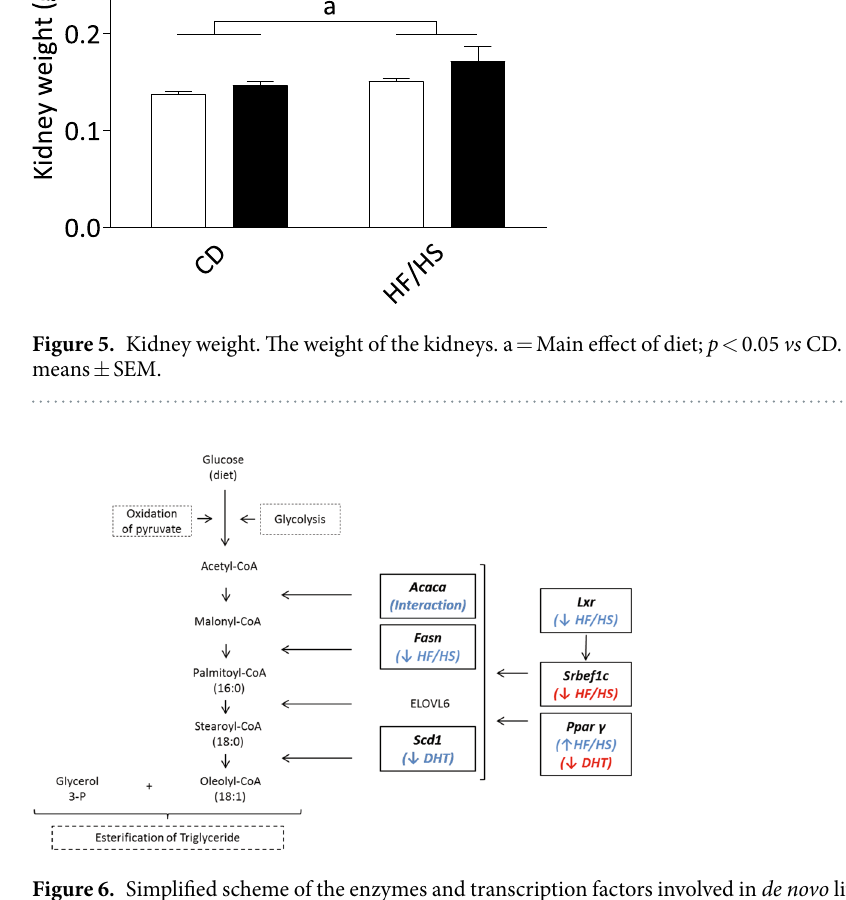
Figure 6. Simplified scheme of the enzymes and transcription factors involved in de novo lipogenesis pathway. Briefly, the enzymes Acetyl-CoA Carboxylase alpha (Acaca), Fatty acid synthase (Fasn), Elongation of very long chain fatty acids protein 6, (Elovl6), and Stearoyl-CoenzimeA desaturase, (Scd1) participate directly in the synthesis and elongation of fatty acids starting from Acetyl-CoA. Liver X receptor regulates the transcription of Sterol regulatory element-binding factor 1, ( Srebf1) , which in turn, stimulates the transcription of the enzymes mentioned above to increase the lipid biosynthesis in the liver. Peroxisome proliferator-activated receptor gamma (Pparg), a master regulator of transcription, also affects the expression level of the proteins in the de novo lipogenesis process. In the figure the molecules studied in this research has been highlighted by bold letters in a square. The blue letters are the changes occurring in the maternal liver. In red are the changes found in fetal